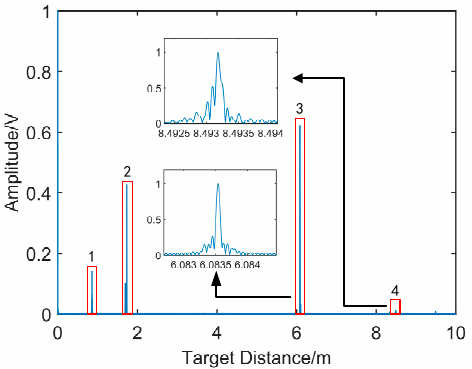
Figure 6. The distance spectra of the resampling signal.